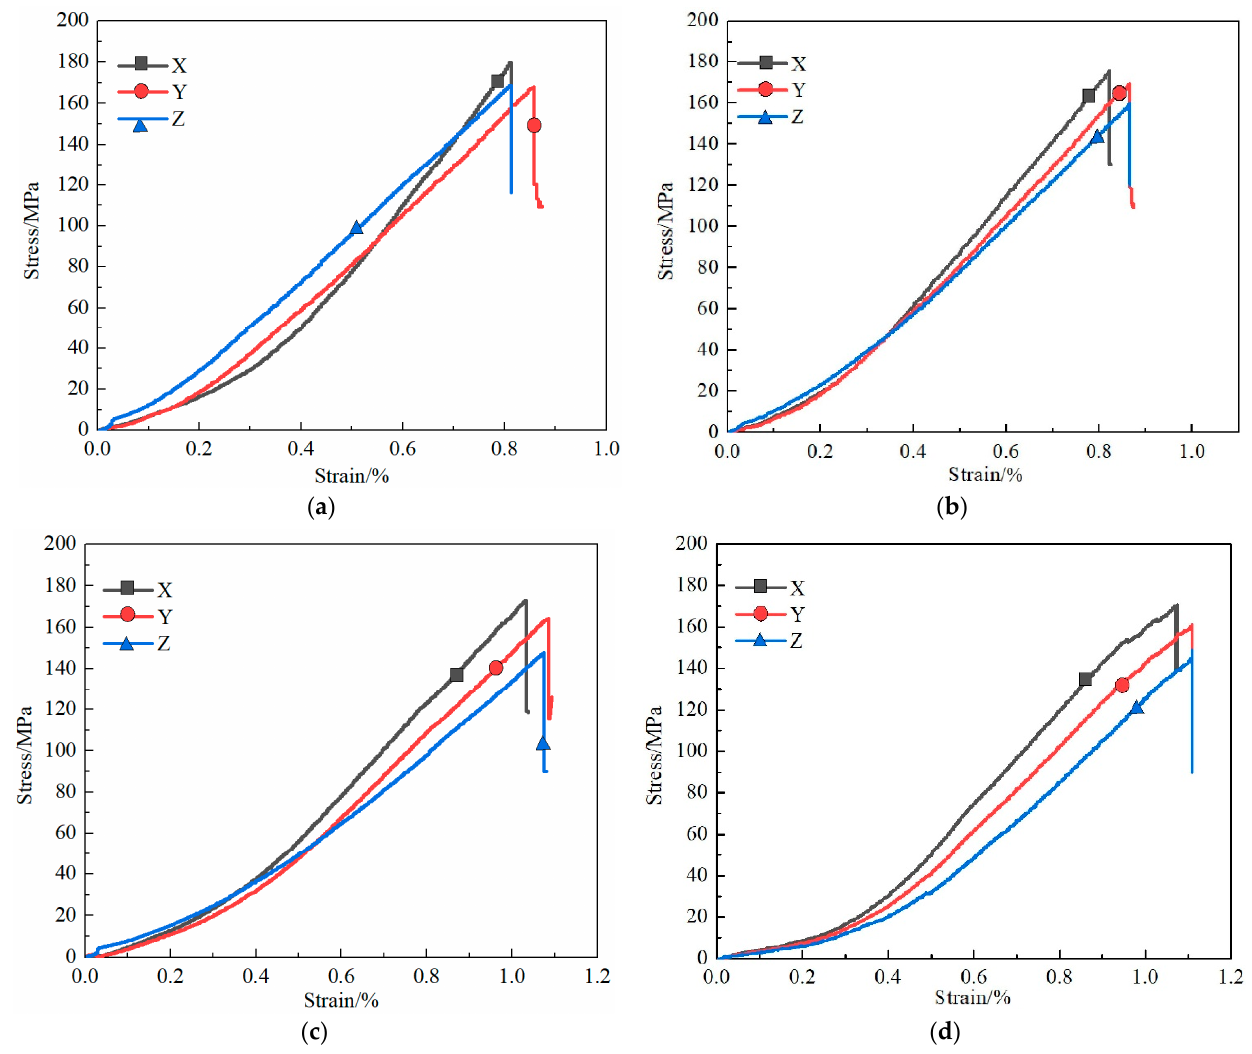
Figure 7. Stress–strain curve of three freeze–thaw cycle treatments at ( a ) 15 cycles; ( b ) 30 cycles; ( c ) 45 cycles; and ( d ) 60 cycles.